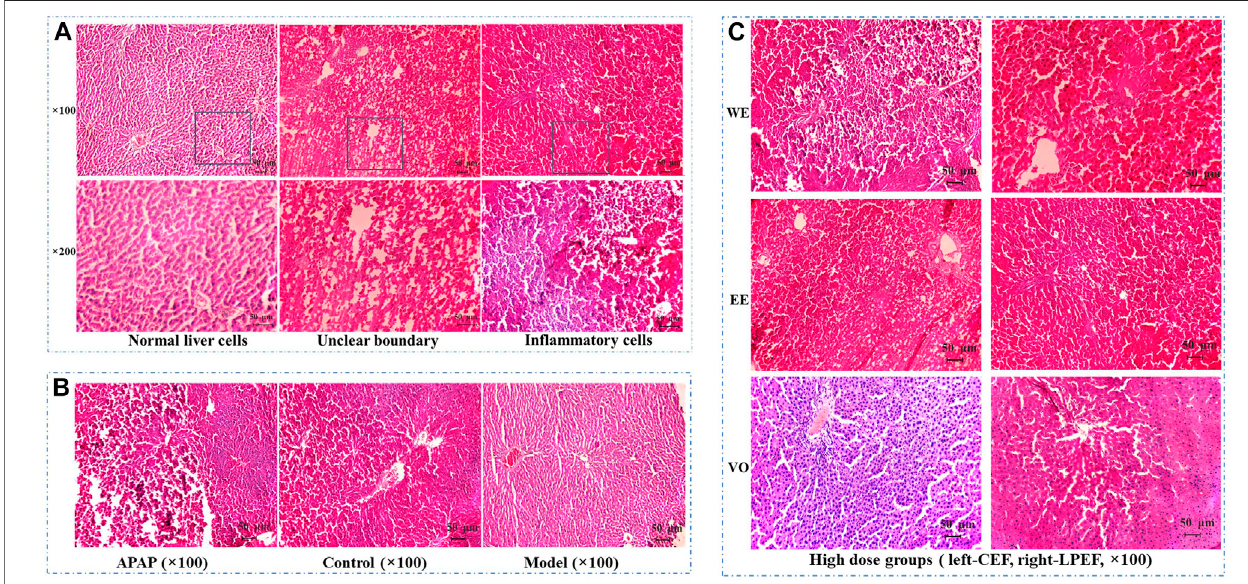
FIGURE9 | EffectsofCEF and LPEF on pathomorphology ofliver issue inrats with stomach excess-cold syndrome treated with different extracts. (A) Normal liver cells and hepatic damage cells. (B) Comparison of APAP group, model group, and control group. (C) High dose groups.